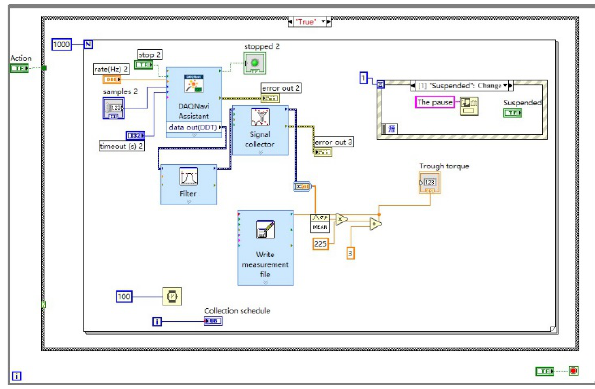
Figure 10. Torque acquisition program block diagram .